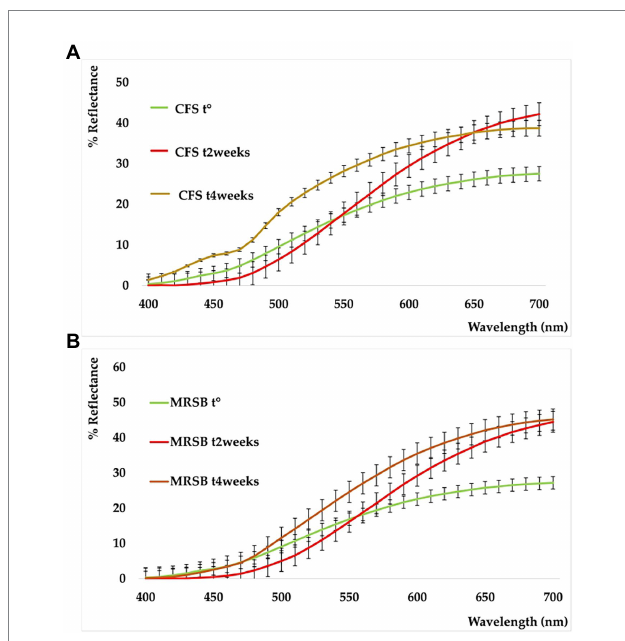
FIGURE 5 Reflectance curves of CFS (A) and planktonic supernatant blank (MRSB) (B) , at t 0 (green), t 2weeks (red), and t 4weeks